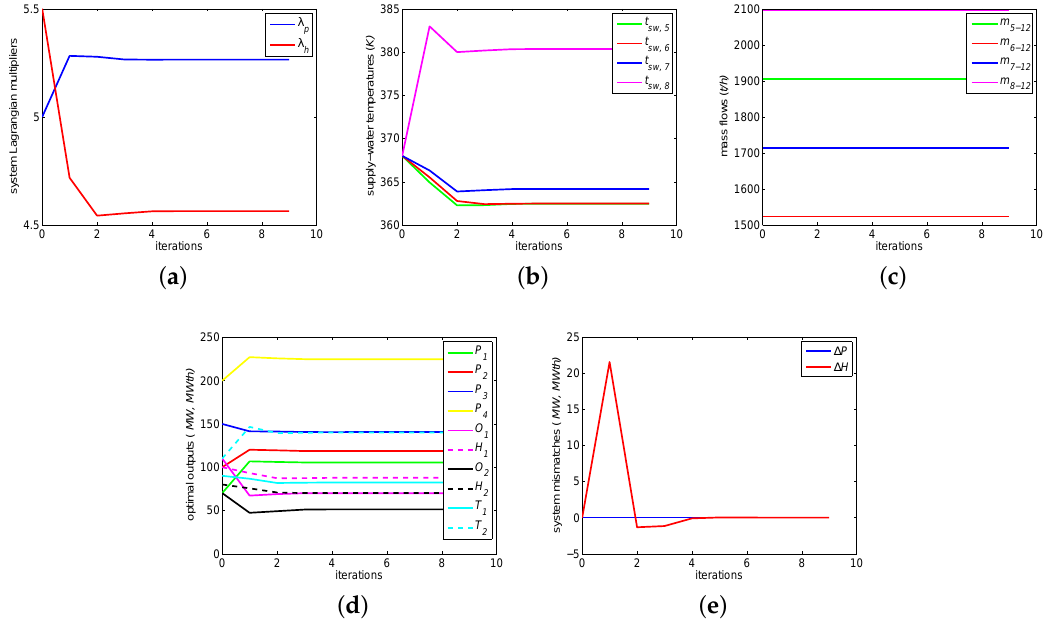
Figure 4. Case study 1: Without output inequality constraints. ( a ) system Lagrangian multipliers; ( b ) supply-water temperatures; ( c ) mass flows; ( d ) optimal outputs; ( e ) system